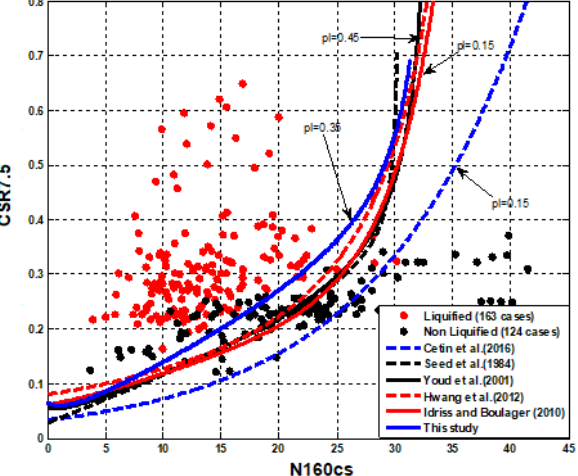
Figure 9: Safety factor according to the depth computed by the 160cs original and corrected versions of the simplified method (Nantou